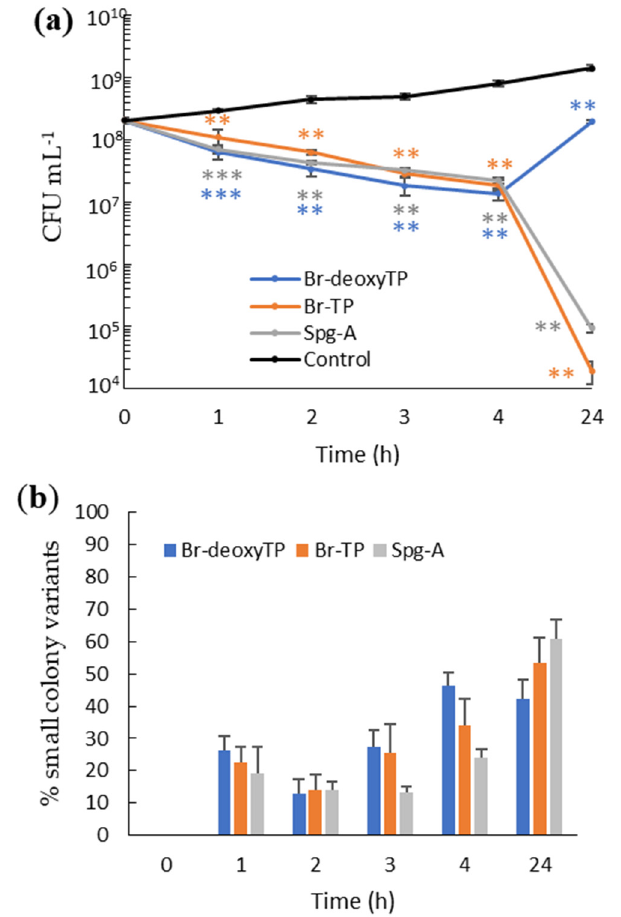
Figure 3. Time-kill kinetics of Br-deoxyTP, Br-TP, and Spg-A at 4X-MIC against MRSA. ( a ) Log reduction of bacterial count. ( b ) Percentage of SCV present in the bis-indole treated cultures at 4× MIC at different time points. Experimental procedure and data analysis and presentation are as described in Figure 2. (** = p < 0.01; *** = p < 0.001). Time-kill kinetic analysis of bis-indole Spg-A against V. parahaemolyticus was also performed (Figure 4). Two-, 3-, and 4-fold log reductions with 4× MIC was observed in viable V. parahaemolyticus after just 15, 30, and 45 min of incubation, respectively. Moreo- ver, no viable bacteria were detected after 1 h of treatment.